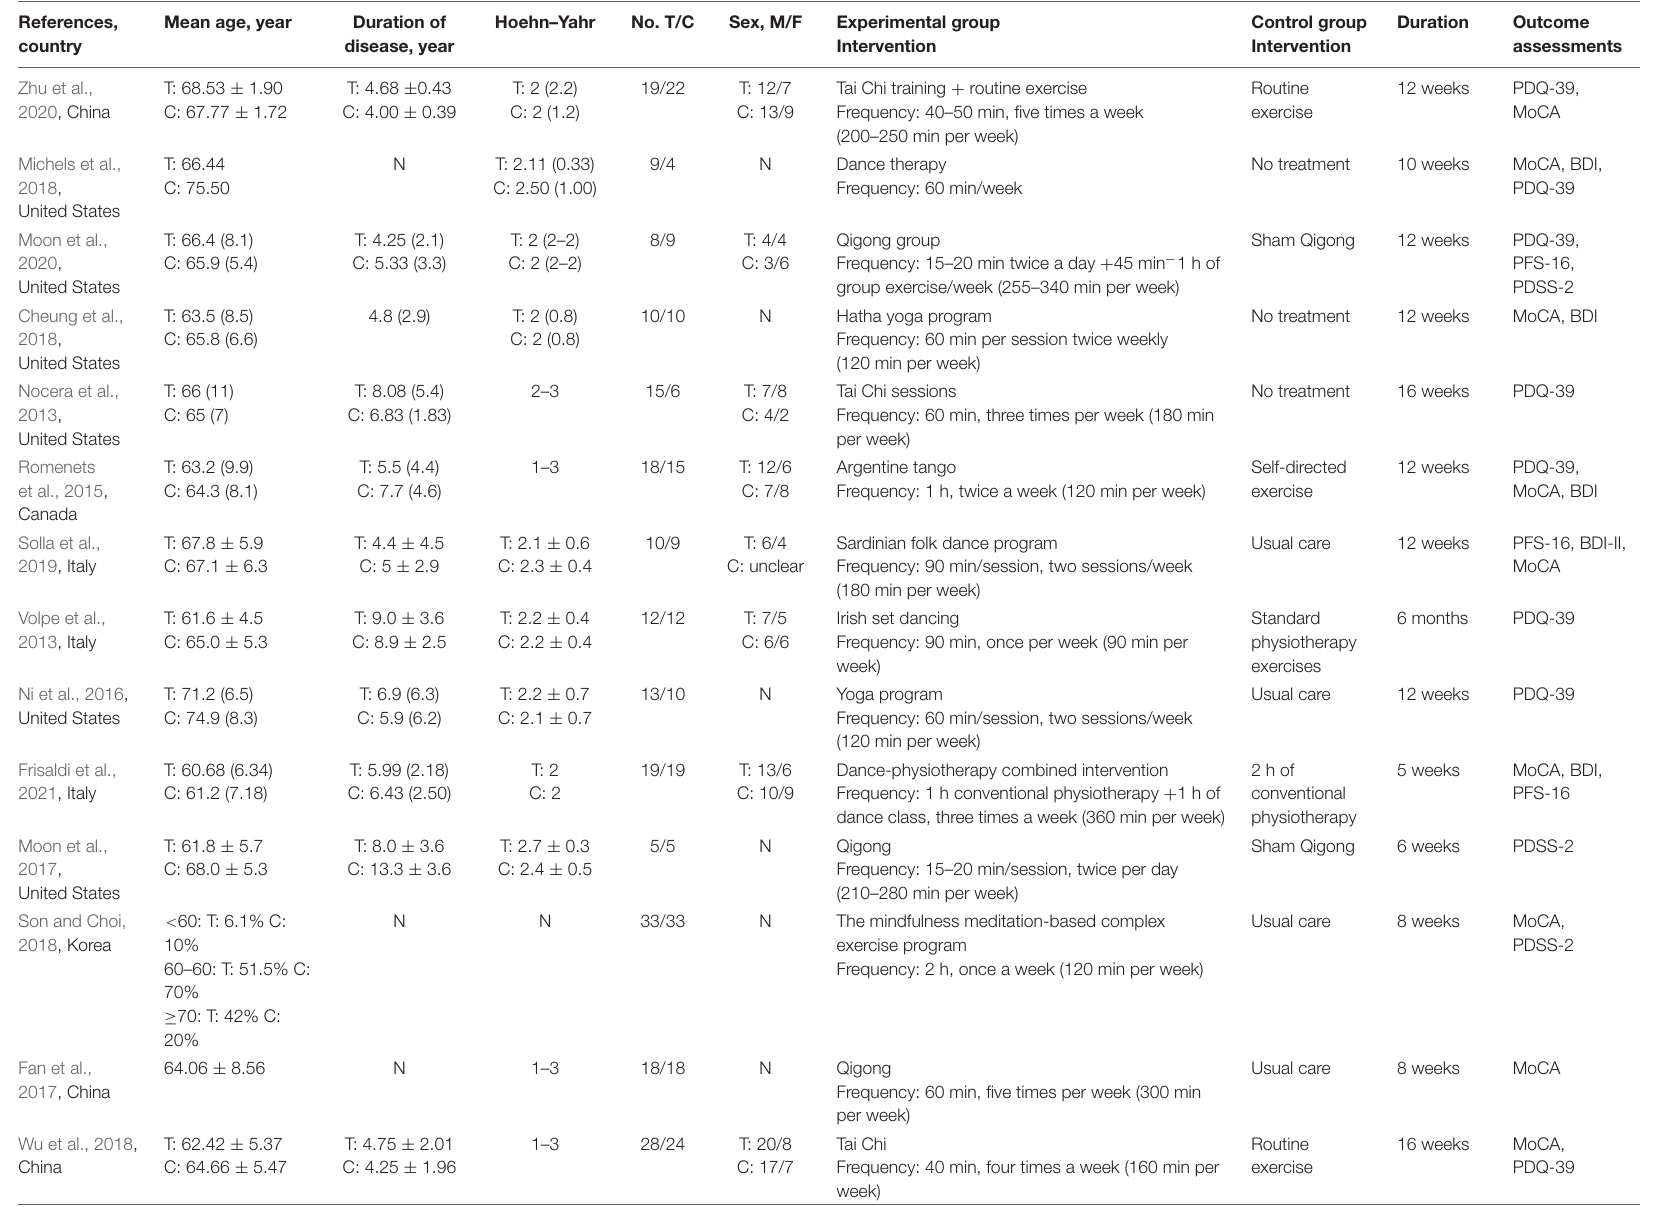
TABLE 1 | Characteristics of randomized controlled trials included in the